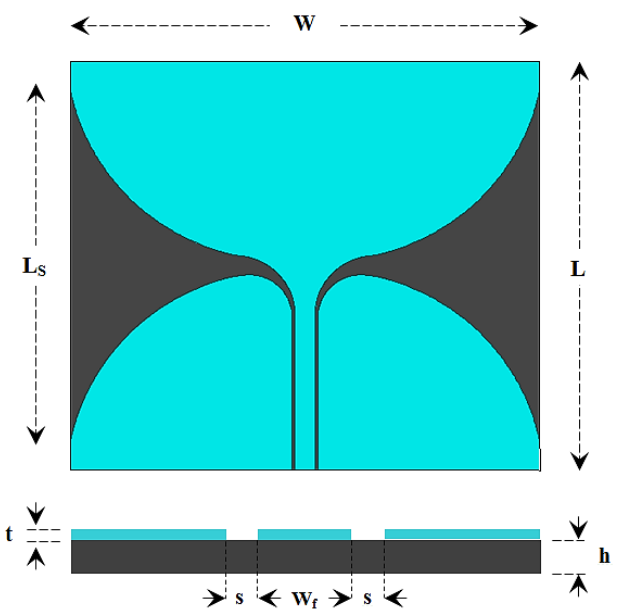
Figure 1: Proposed bi-directional antenna. Table 1: Proposed antenna optimal parameters. Parameters